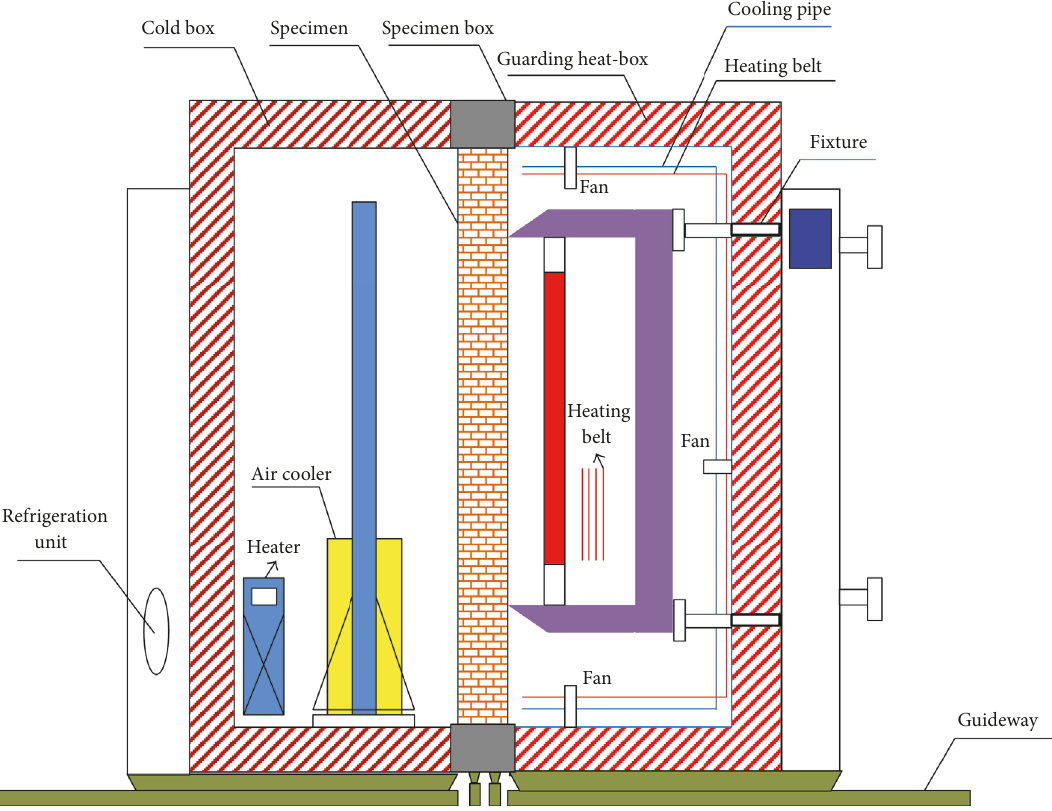
Figure 5: Schematic of the test machine for steady-state heat